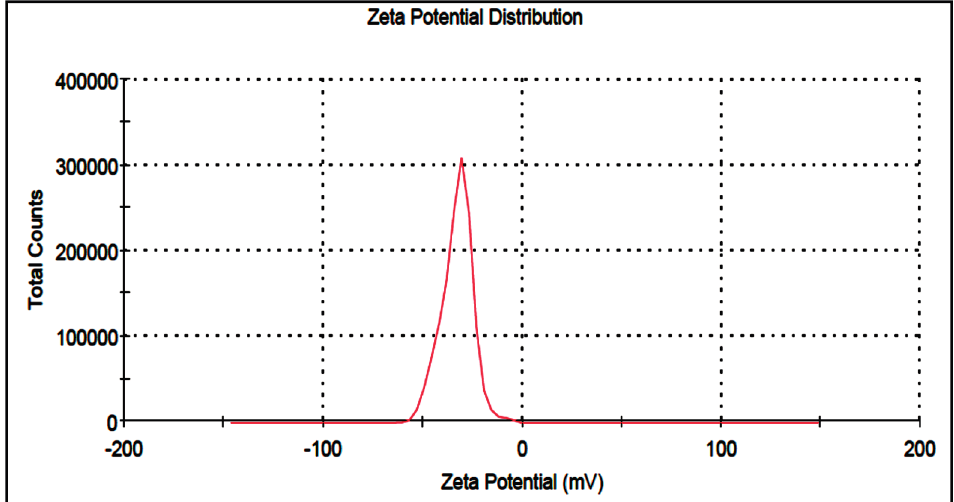
Figure 7. Zeta potential of Ag-NPs synthesized using sumac .